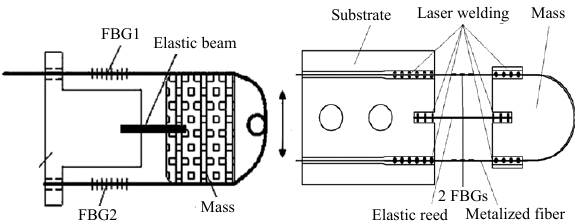
Fig. 23 Structure of the FBG vibration sensor.